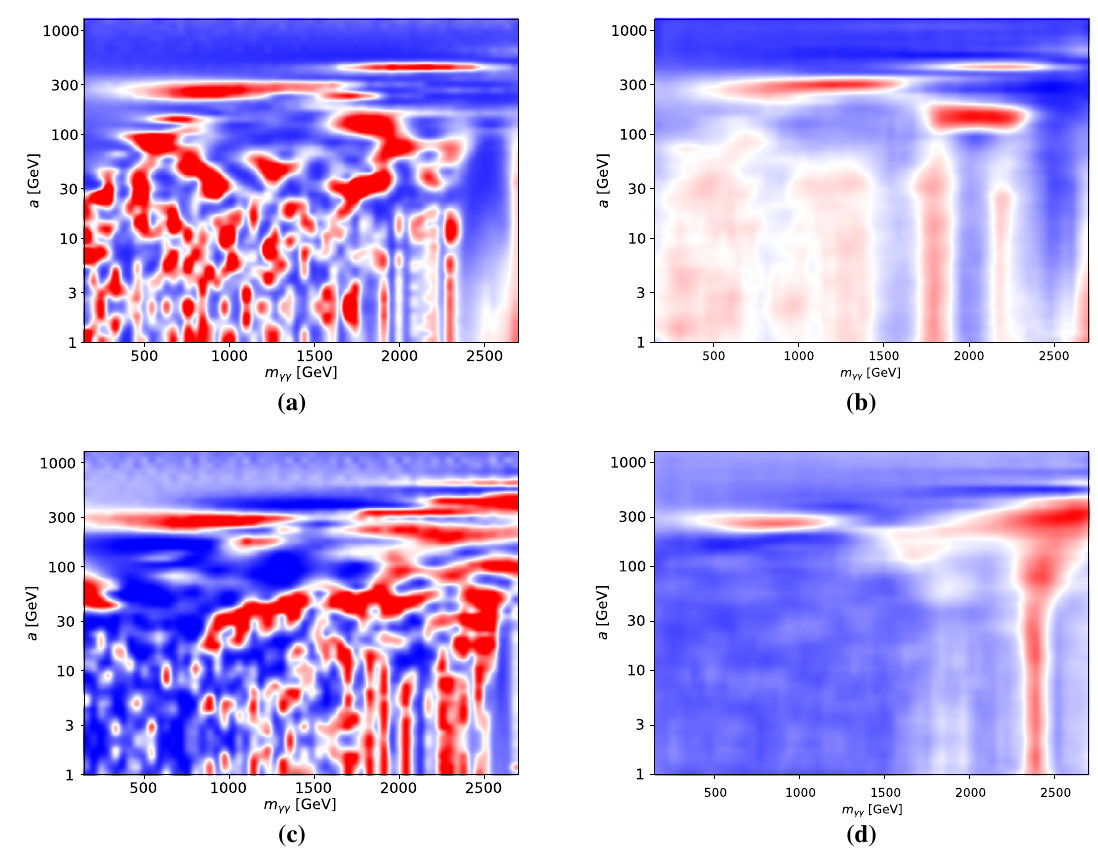
Fig. 6 Examples of the input and output of the autoencoder. a → b Background-only sample and its reconstruction after encod- ing. c → d Sample containing a signal and its (mis)reconstruction